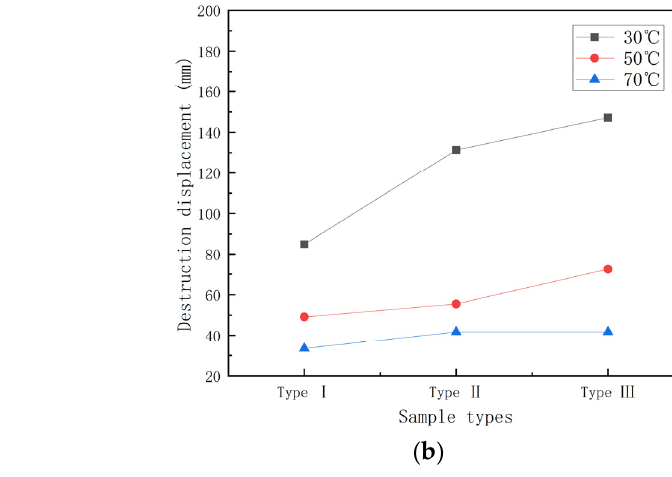
Figure 10. Destruction displacement curve for GFRP pipes. ( a ) Destruction displacement–temperature curve; ( b ) Destruction displacement–sample type curve.